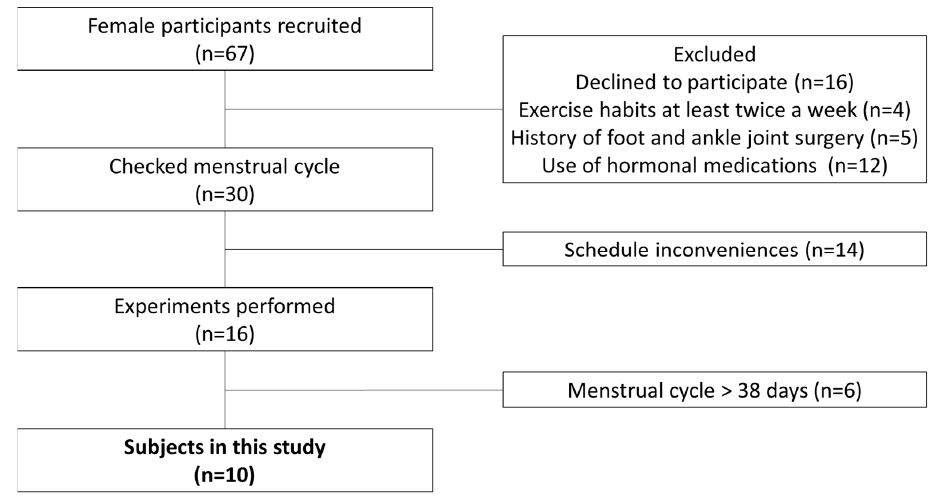
Figure 1. Flowchart for selection of female participants.